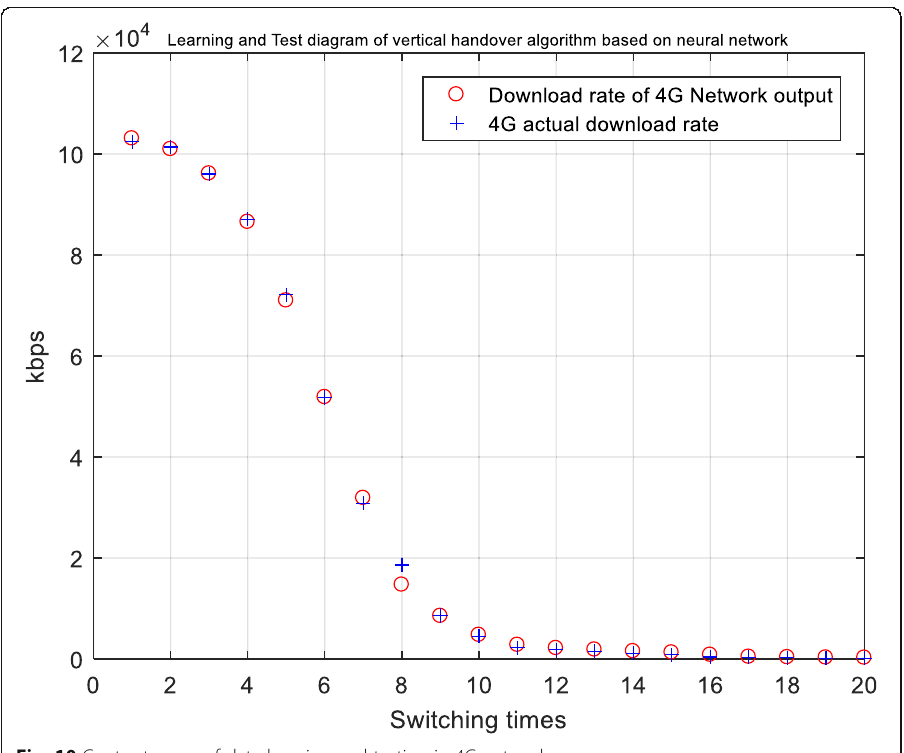
Fig. 10 Contrast curve of data learning and testing in 4G network